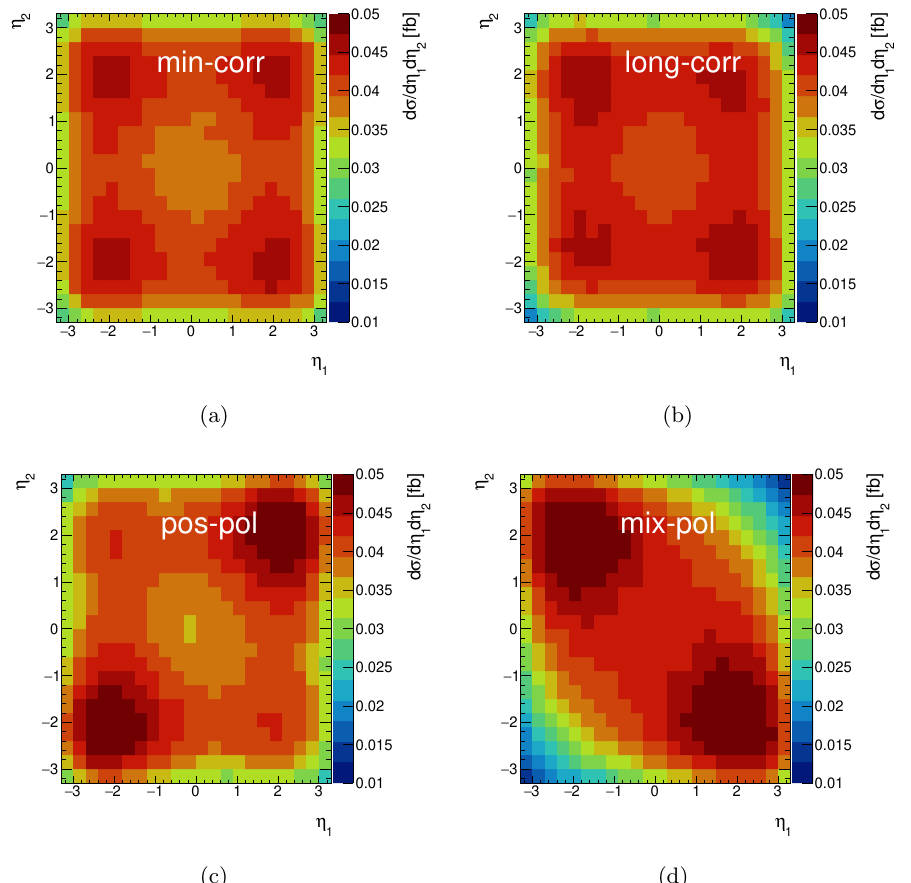
Figure 2 . Double-di(cid:11)erential distributon for rapidity of the two muons, with cuts as in (4.1). Top left: minimally correlated scenario. Top right: longitudinal correlation. Bottom left: positive polarization. Bottom right: mix